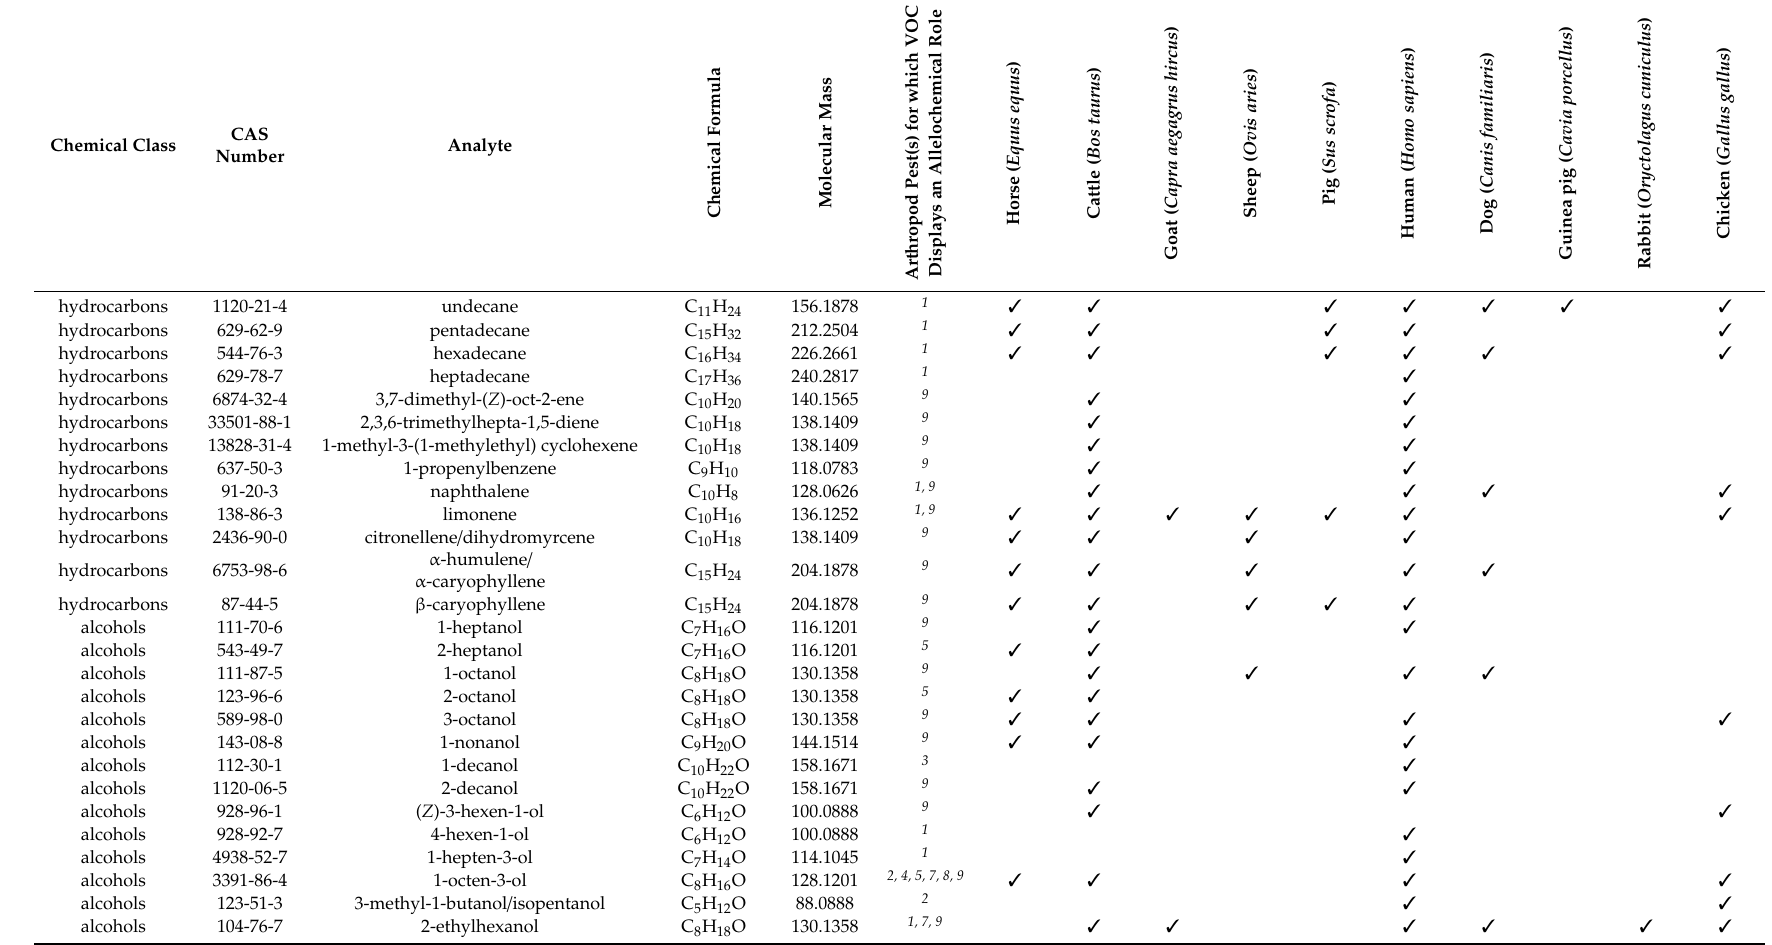
Table 1. A selection of the total (1287) volatile organic compounds (VOCs) collated from the literature from mammalian and avian emissions. The full table (Supplementary File 1) lists and compares the VOCs identified in 141 species across 17 orders. The compounds displayed in this excerpt, from a selection of domestic species, are those with physiological and / or behavioural evidence of allelochemical function in arthropod species of medical or veterinary